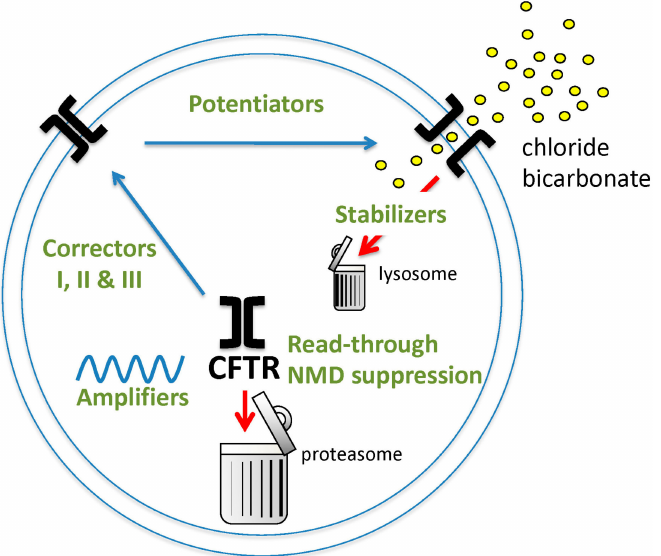
Figure 3. Pharmacological strategies for restoring CFTR function in CF individuals with various classes of CFTR mutations. Illustrated in green are agents that increase the open probability of CFTR (potentiators), facilitate escape of misfolded protein from ERAD (correctors of class I act on NBD1, class II on NDBII and class III have an additive corrector effect in the presence of class I corrector), increase the amount of CFTR mRNA (amplifiers), increase proper translation of mRNA with PTC mutations (read-through agents), decrease NMD (NMD suppressor) and prevent degradation of CFTR protein inserted in the plasma membrane